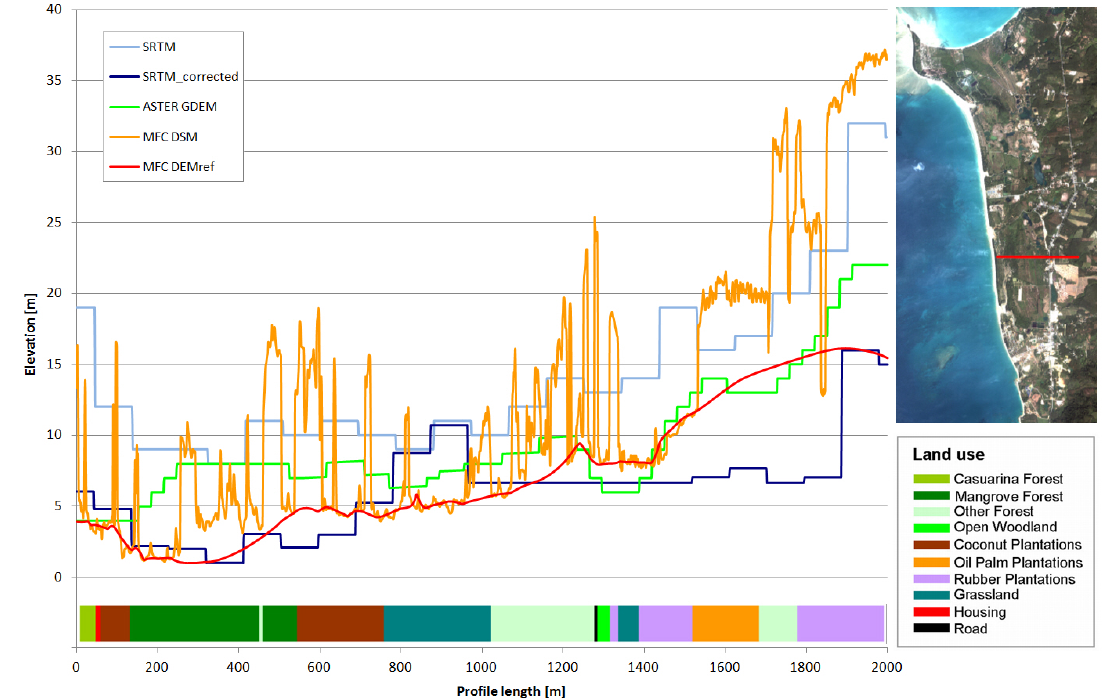
Fig. 6. Cross section showing the height offsets due to LULC for the different elevation models.